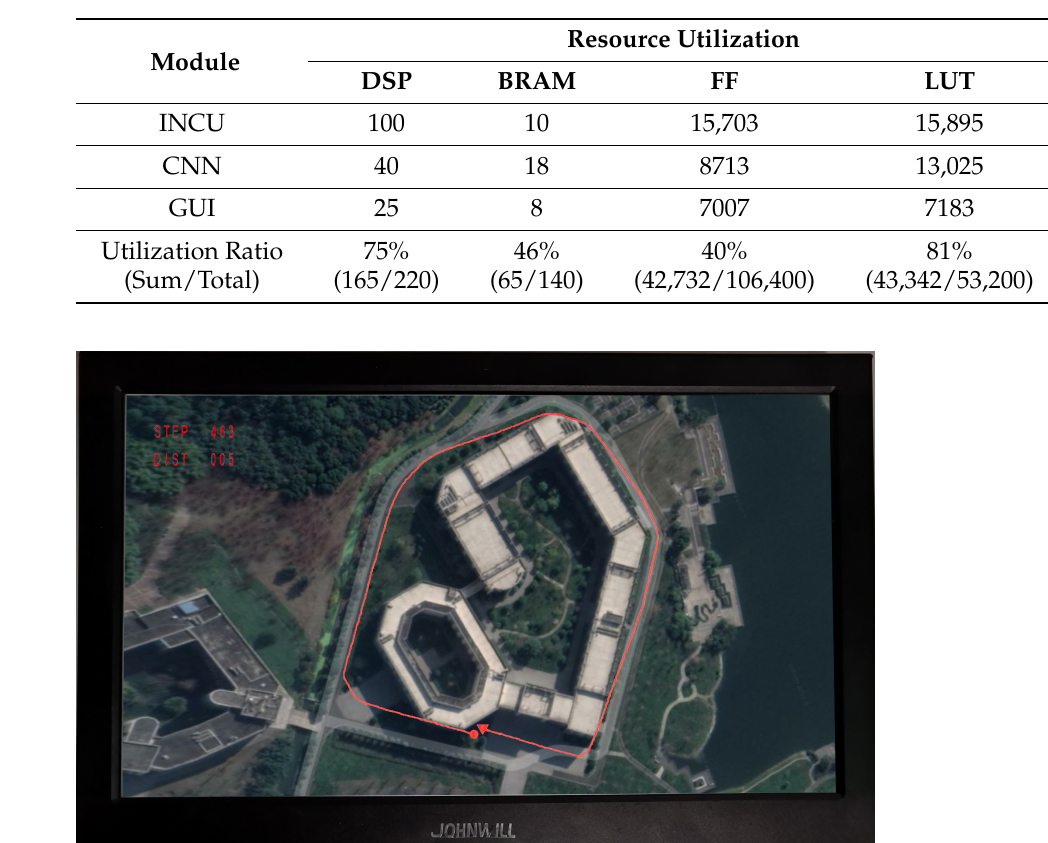
Figure 11. Effect of a complete running trajectory by the PDR terminal. The small triangle and the circle represent the starting point and the endpoint, respectively. STEP indicates the number of steps the test subject walked (the length of a STEP is the distance that the person moves when his/her left and right feet move once). DIST indicates the distance between the person’s current position and the starting point. Note that we chose to test on the running trajectory, which is the most difficult to predict among the three motion types, to prove the reliability of our PDR